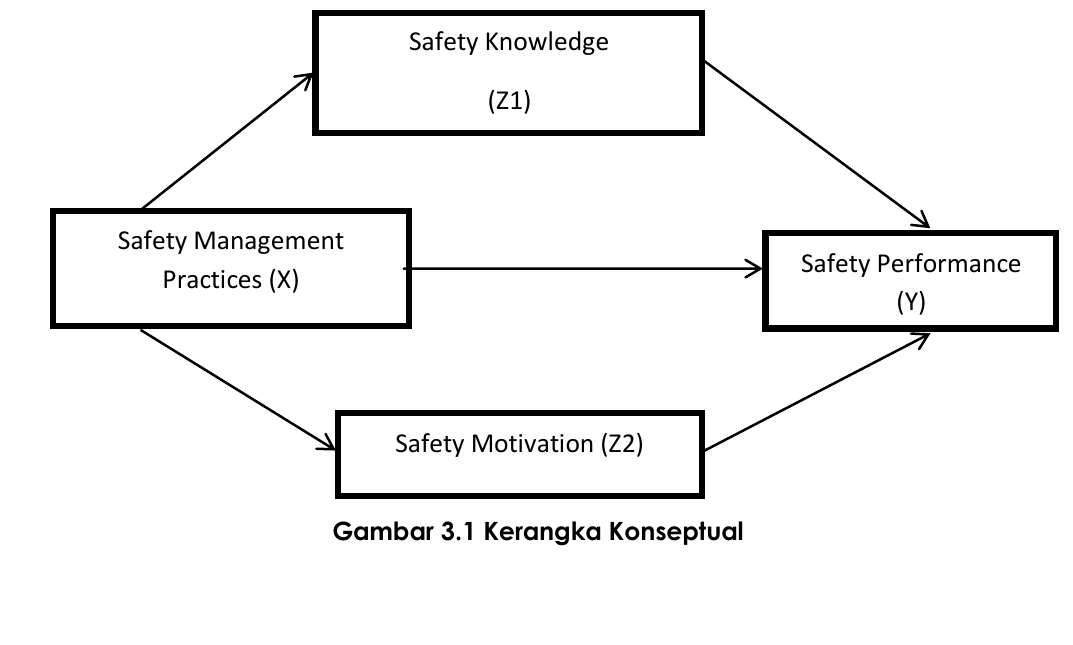
melalui safety motivation